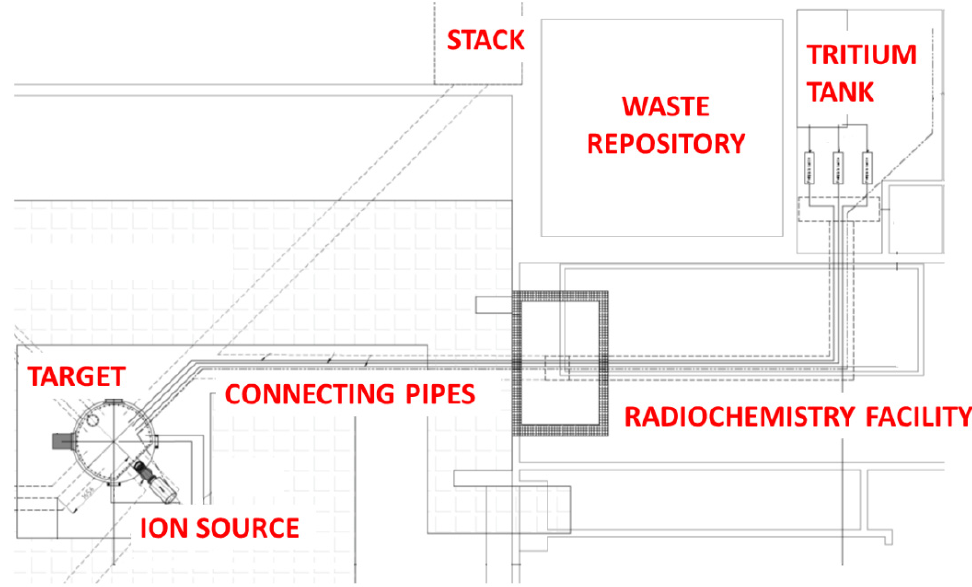
Figure 1. Preliminary layout of the Sorgentina-RF plant: the irradiation facility (with the ion source and the rotating target) and the tritium room (which hosts the tritium tank) are highlighted, with the pipes connecting the two.